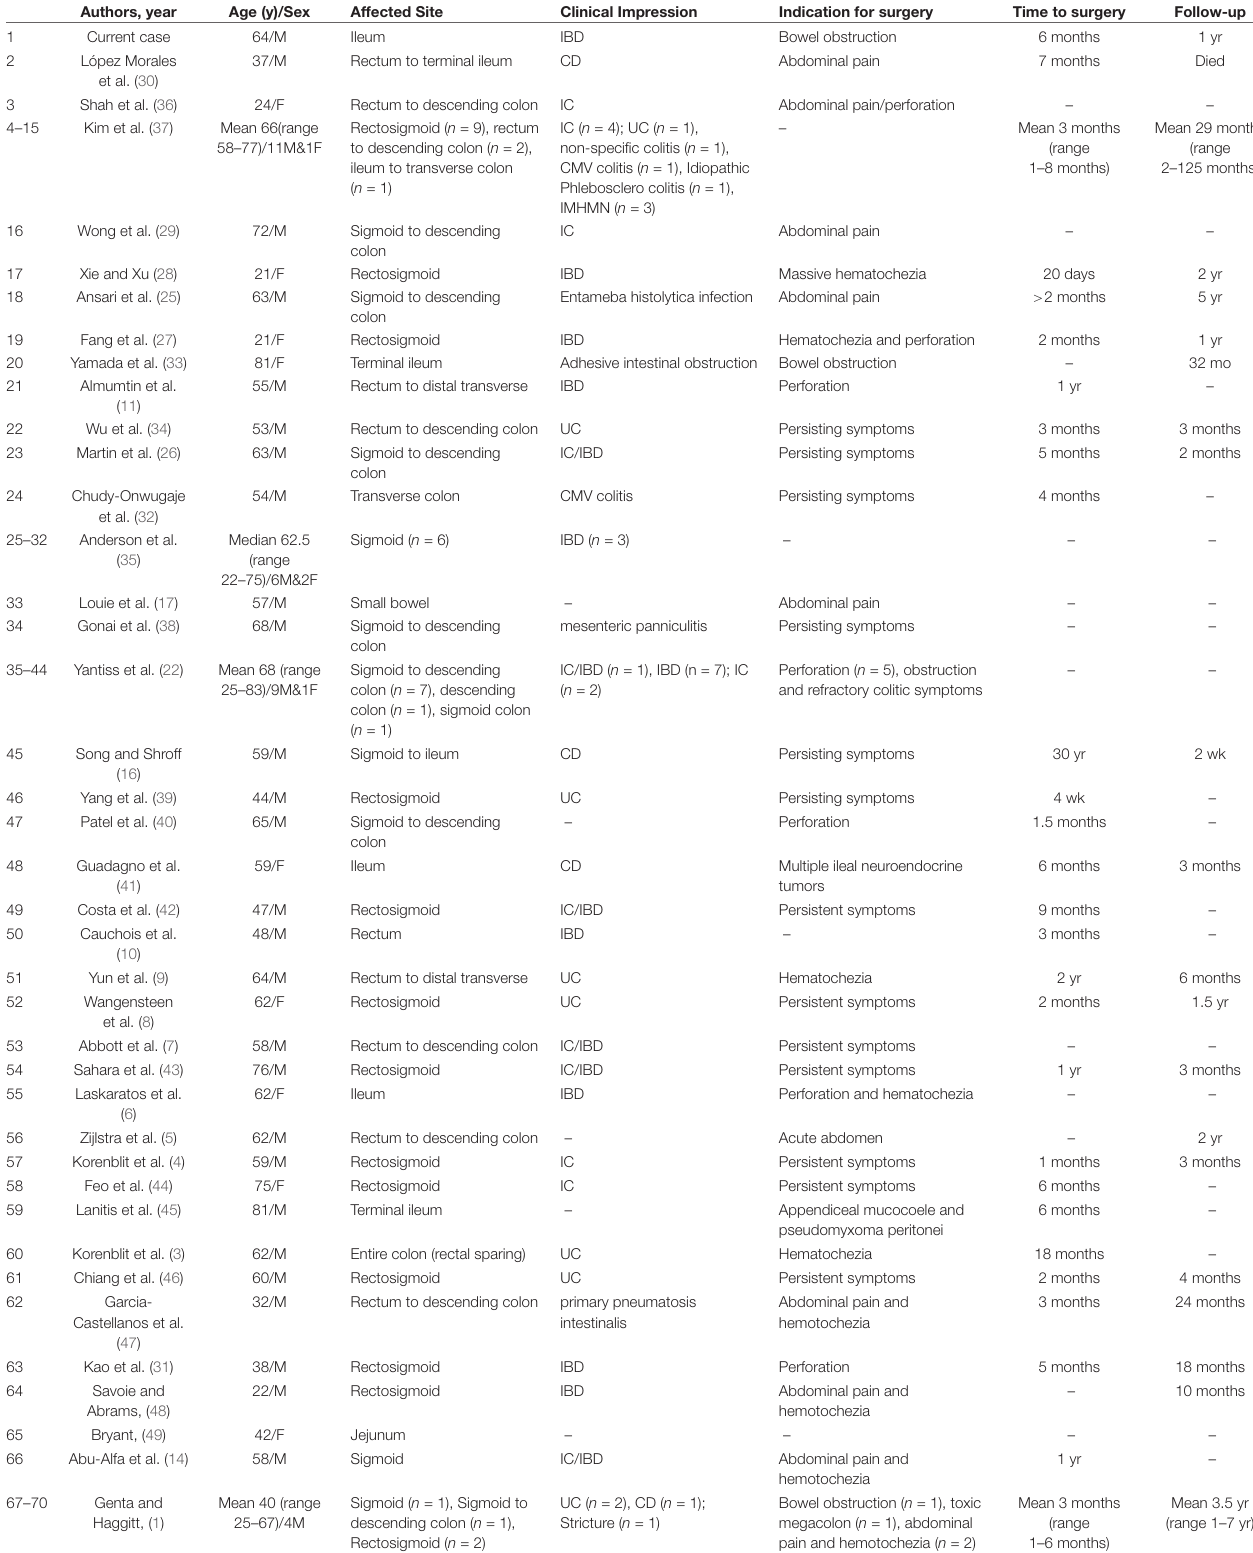
TABLE 1 | Clinical characteristics of all reported cases of IMHMV to